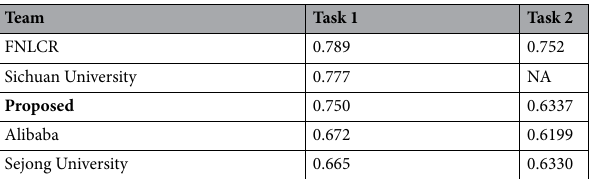
Table 8. Top five entries of PAIP 2019. Task 1 corresponds to Viable tumour segmentation and Task 2 corresponds to Viable tumour burden estimation. Note: FNLCR: Frederick National Laboratory for Cancer